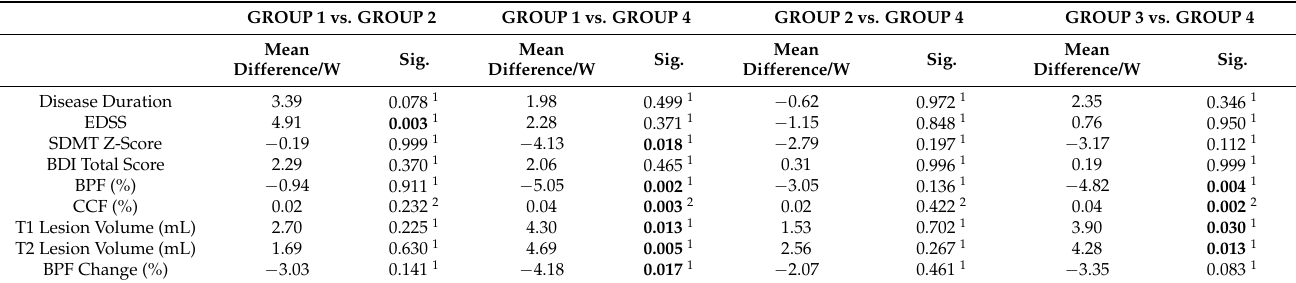
Table 2. Post-Hoc pairwise comparison of selected subgroups at